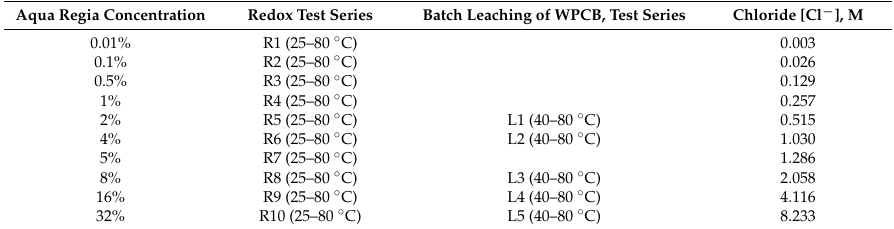
Table 2. Aqua regia concentrations and corresponding chloride concentration in the redox test series (R1–R1) and in the batch leaching test series used in WPCB leaching (L1–L5). In addition, the temperature range investigated in the test series R1–R10 and L1–L5 is presented.